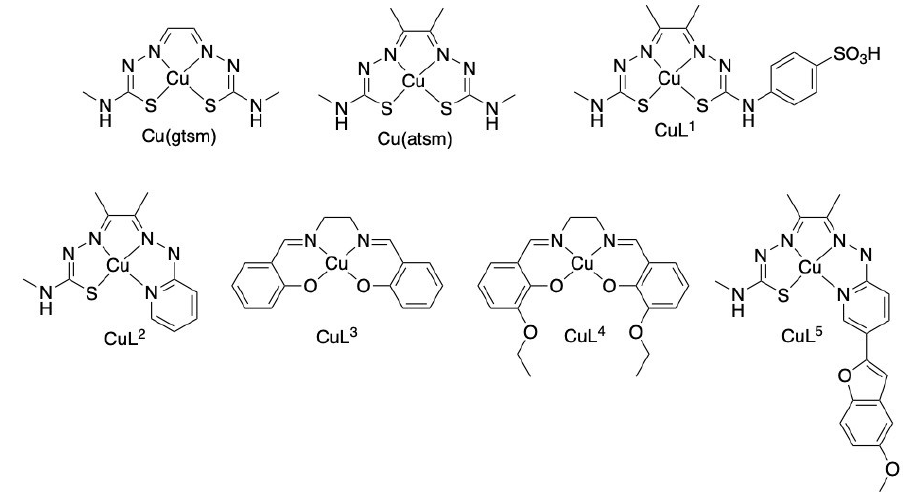
Figure 1. Chemical structures of tested copper(II) compounds Cu II (gtsm), Cu II (atsm), CuL 1−5 .